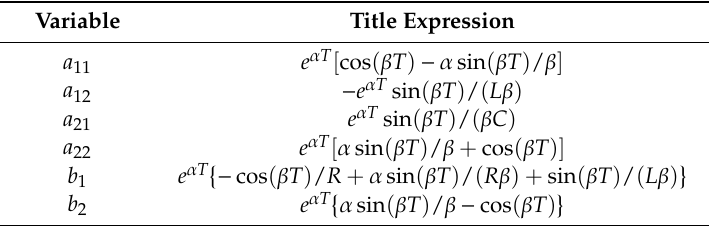
Table 1. Variables in Equation (18).